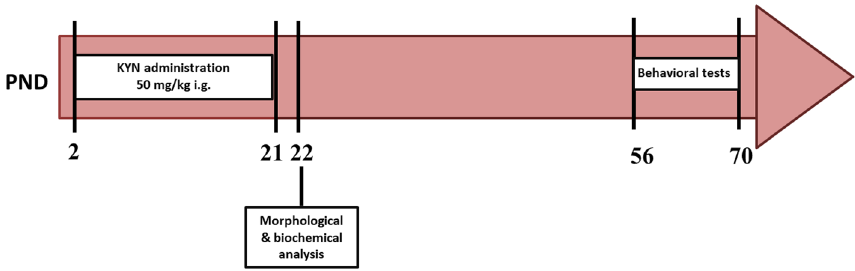
Figure 5. Schematic representation of experimental study design and analysis. PND postnatal day, i.g. intragastrically, KYN kynurenine, PND postnatal